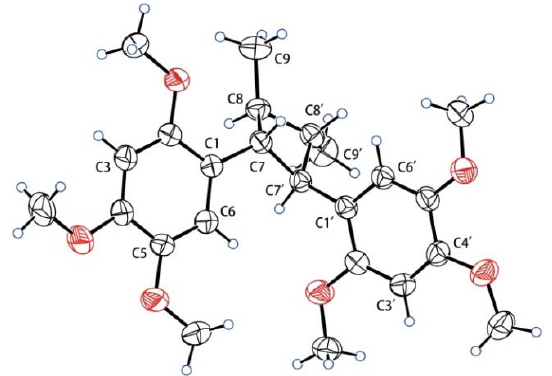
Figure 3. X-ray crystallographic structure of 2 Figure 3. X ‐ ray crystallographic structure of 2 .